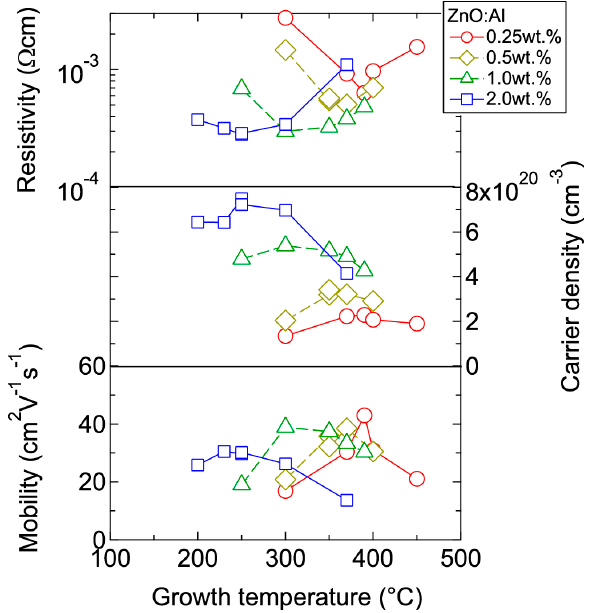
Figure 4. Plots of resistivity, carrier density, and mobility in ZnO:Al (0.25, 0.5, 1.0, and 2.0 wt %) films as a function of growth temperature.